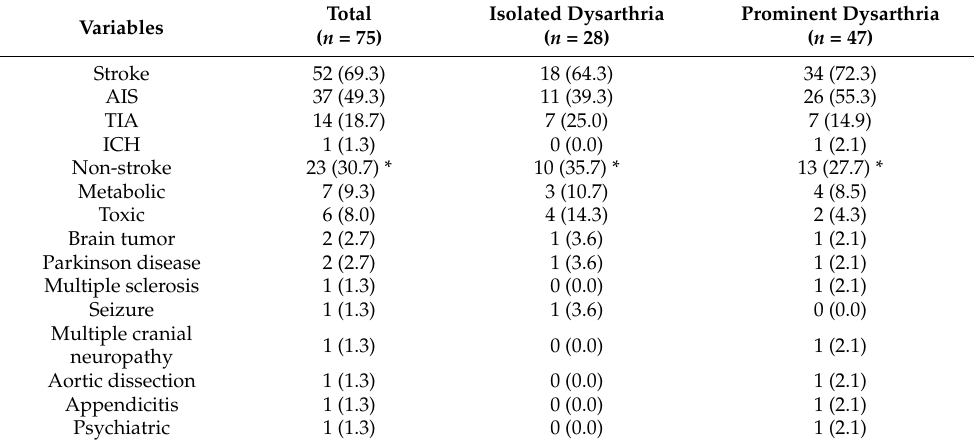
Table 2. Final diagnosis of patients with isolated or prominent dysarthria.